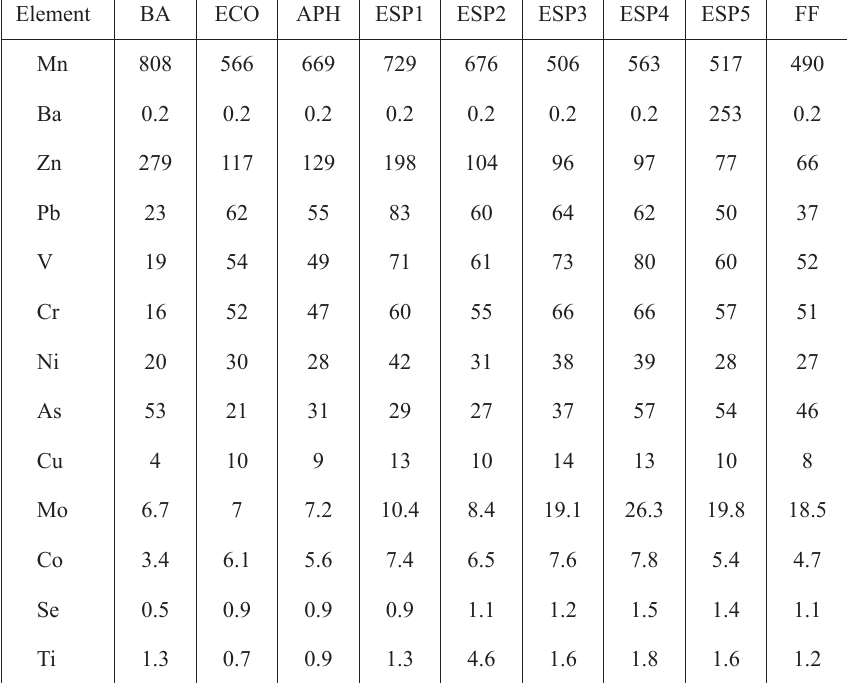
Table 3. Trace element composition of Auvere CFBC oil shale ash samples, ppm